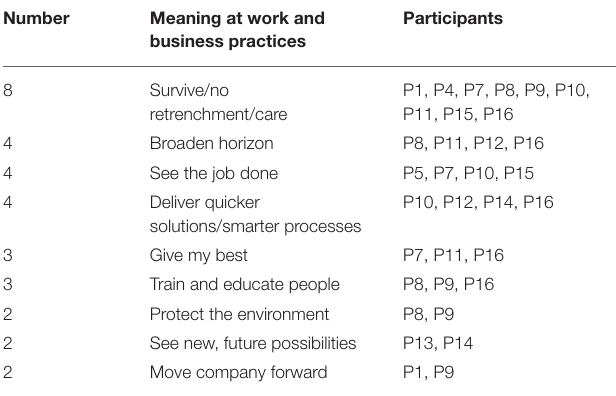
TABLE 5 | Meaning and sustainable I4.0